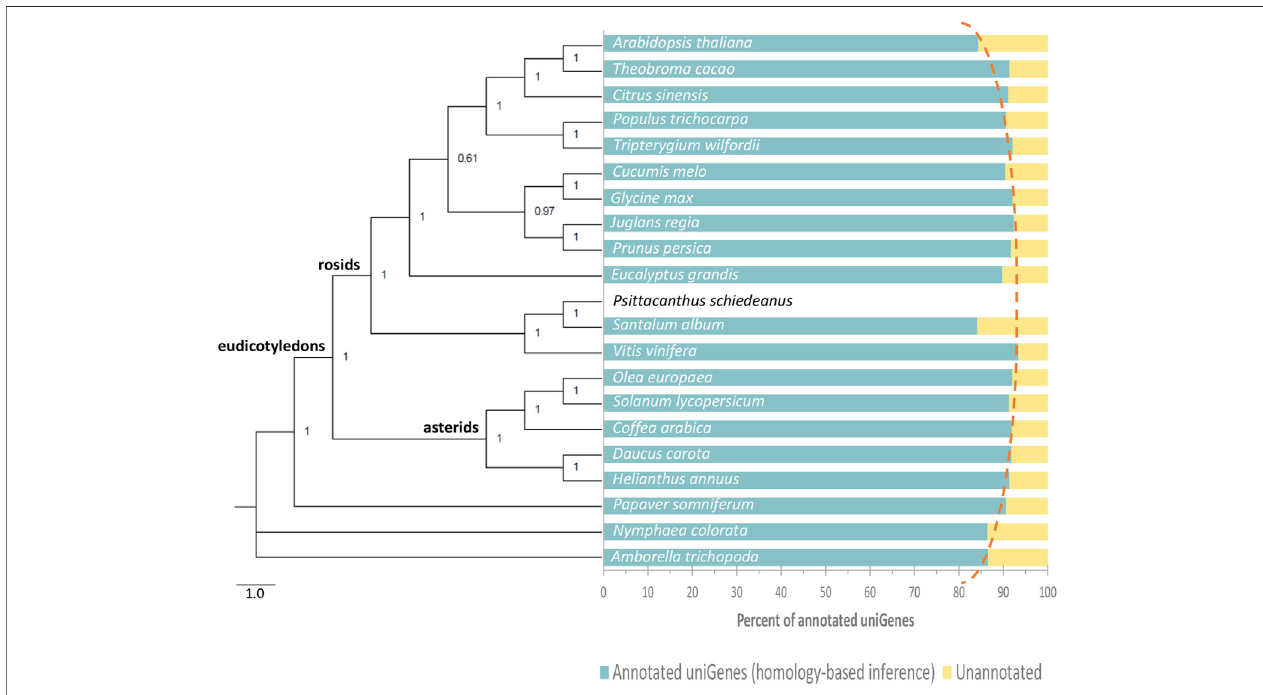
FIGURE 2 | Phylogenetic tree and percent of Psittacanthus schiedeanus genes annotated by homology-based inference. The Bayesian phylogenetic tree (on the left) was constructed based on 17 single-copy orthologs nuclear genes (a total of 19,692 nt) shared among 21 angiosperm plant species analyzed. Numbers near the nodes indicate Bayesian posterior probabilities. On the right of the phylogenetic tree and for each plant species included, the percent of P. schiedeanus uniGenes that were annotated based on their homologous proteins. Homolog ’ s search was carried out by using the BLASTp algorithm (cut-off e -value of 10 − 5